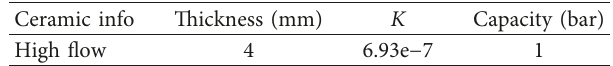
Table 4: Porous ceramic plate properties (porous ceramic plate, 4mm thickness, 1 bar high flow).